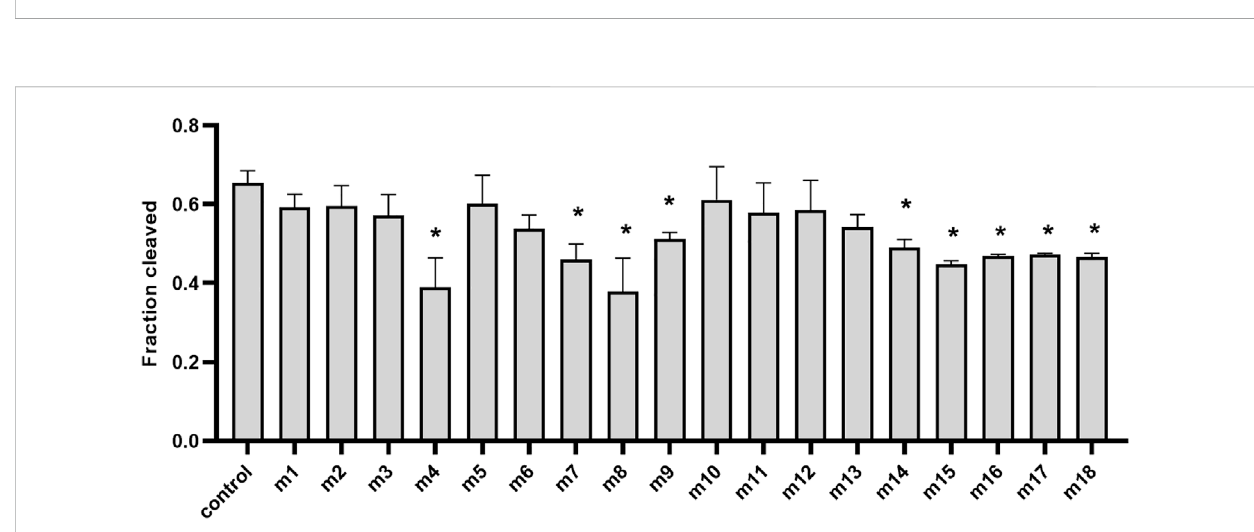
FIGURE 5 Effects of guide – target mismatches on target cleavage. Data are given as the mean ± SD from three independent measurements. * represents a signi fi cant difference (0.01 < p -value < 0.05), and ** represents p -value < 0.01. The control reaction contained guide without mismatches. The reaction was performed with 18-nt 5 ′ -P-gDNA at 75 ° C for 30 min, and all experiments were performed with Ttd Ago, guide, and target at the molar ratio of 4:4:1 (800 nM Ttd Ago preloaded with 800 nM guide, plus 200 nM target) in the reaction buffer containing 5 mM Mn 2+ . Statistical analysis was performed using Student ’ s